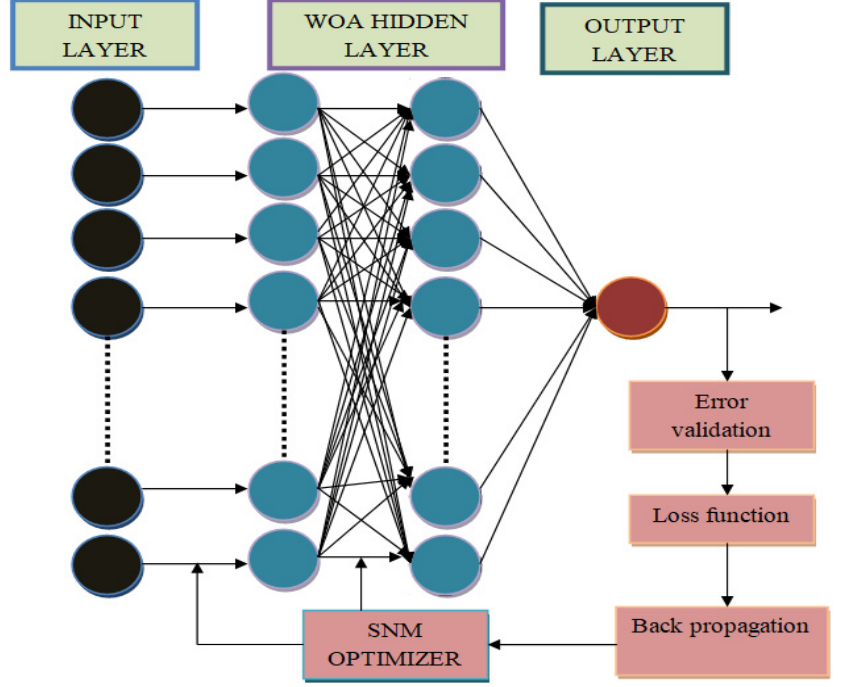
Figure 5. Proposed WOA-ANN architecture.